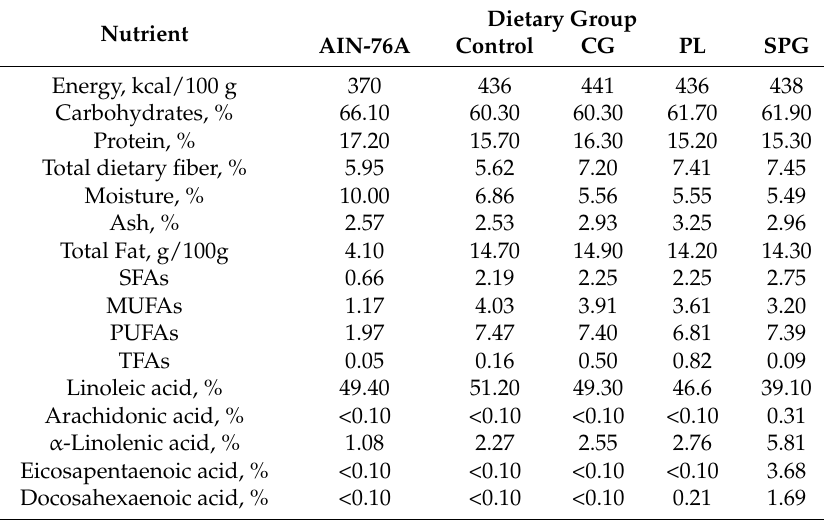
Table 2. Nutrient composition * of experimental